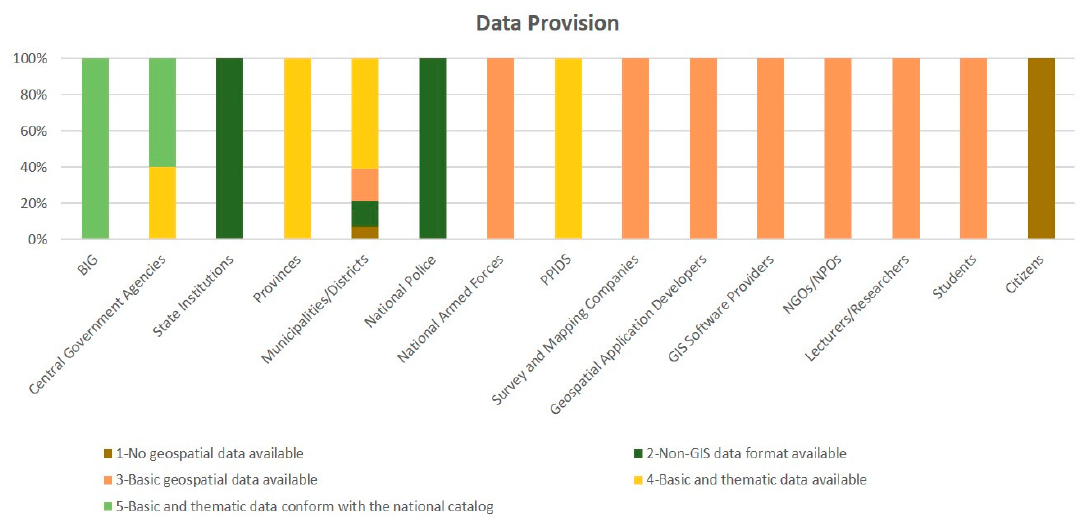
Figure 4. Questionnaire results on data provision of the stakeholders. Center for SDI Development (Pusat Pengembangan Infrastruktur Data Spasial; PPIDS), non-governmental organizations (NGOs) or non-profit organizations (NPOs).